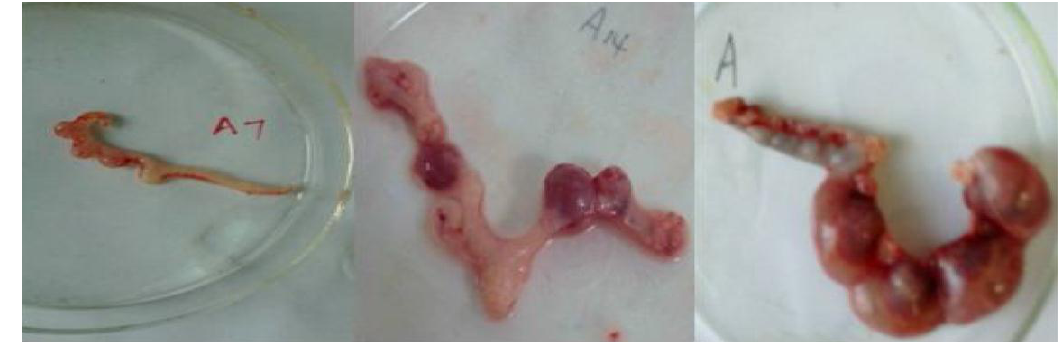
Figure 2. The abnormal presence of three uteri in pregnant rats with less than 4 offspring in the DecaBDE-treated group.